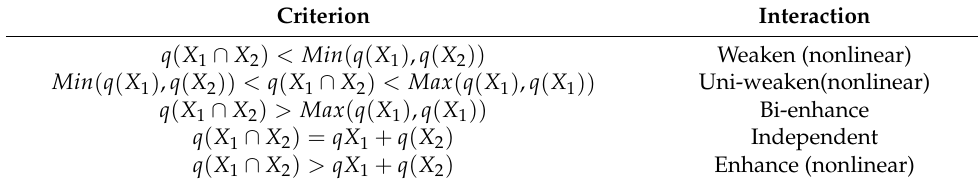
Table 2. Interaction classification criteria. Criterion